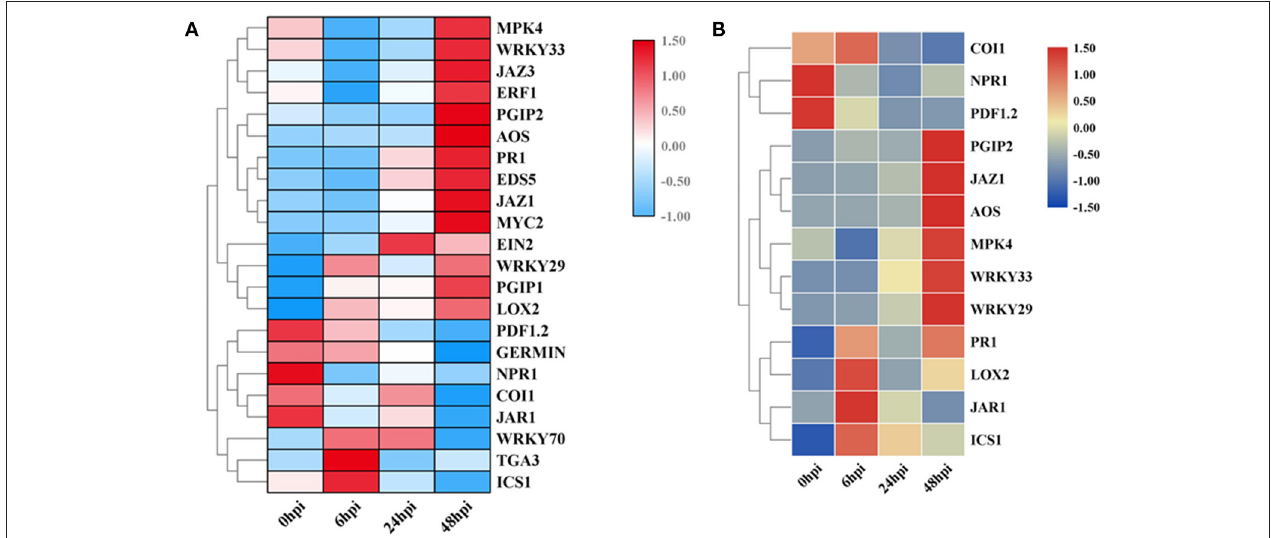
FIGURE 4 | Validation of the expression of 22 genes by quantitative reverse transcription PCR (qRT-PCR). (A) The expression-level changes based on qRT-PCR data. (B) The expression-level changes based on RNA-seq data. Gene IDs are listed in Supplementary Table 1